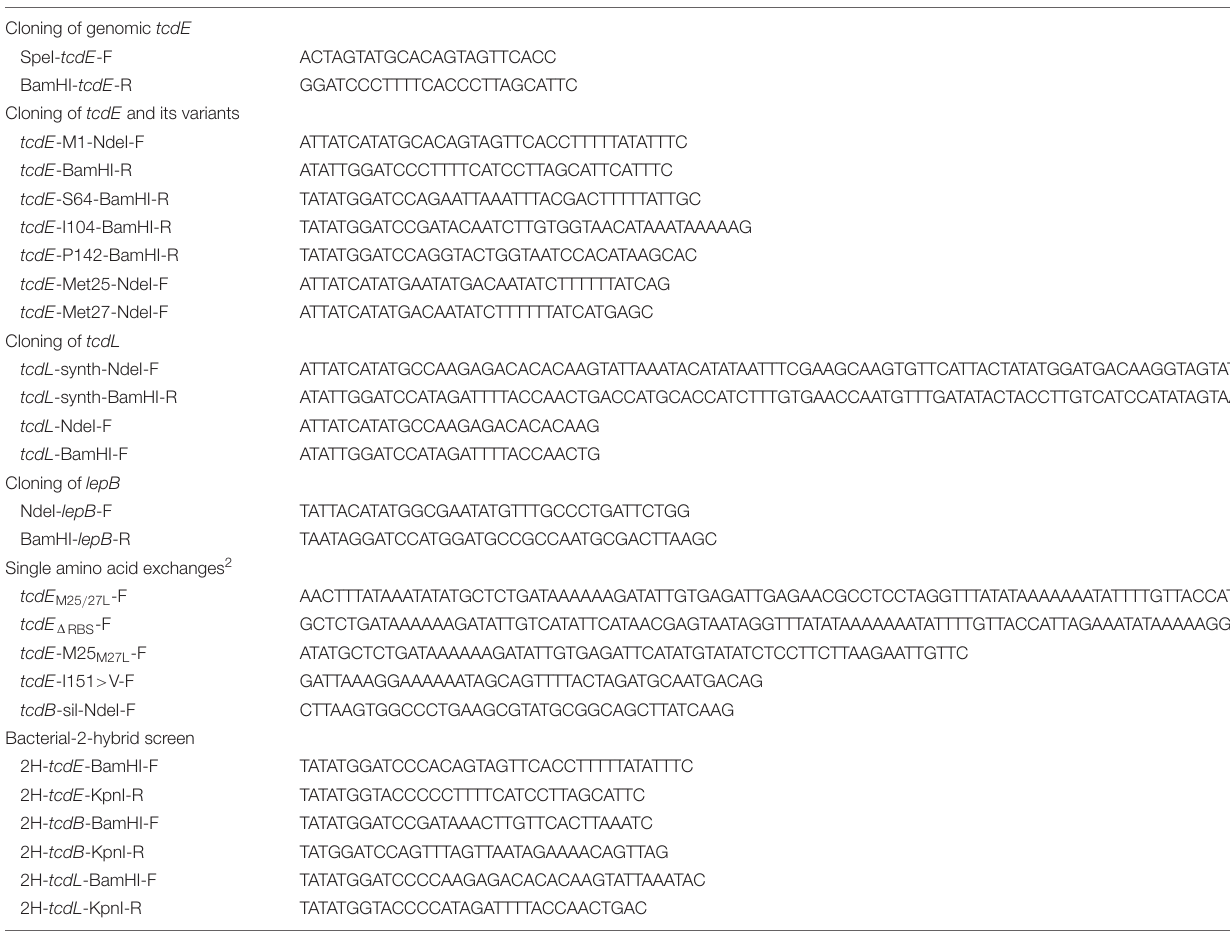
TABLE 1 | Primers used in this study 1